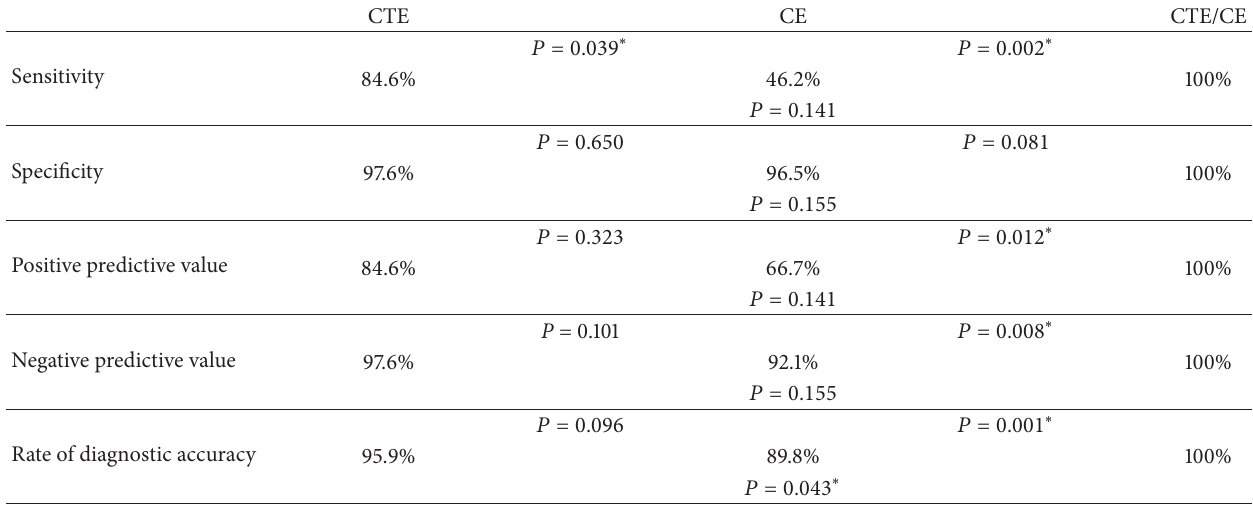
Table 4: Comparison of computed tomography enteroclysis/enterography (CTE) and capsule endoscopy (CE) in terms of detecting the neoplastic